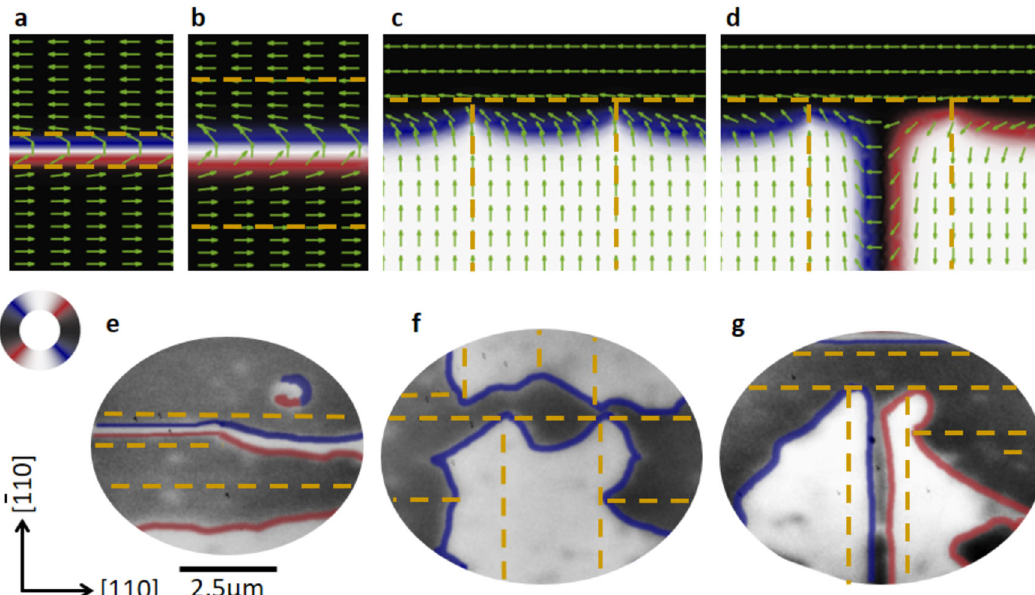
Fig. 4 Micromagnetic simulations. a – d Micromagnetic simulations of the AF domain structure in areas with different microtwin patterns (indicated by the broken yellow lines). a , b Feature parallel microtwins 2 domain wall widths apart ( a ) and two 7 domain wall widths apart ( b ). c , d The simulation results for different initial conditions for the same microtwin pattern of one perpendicular and two parallel microtwins forming two T-junctions. The green arrows (in a – d ) and color wheel show the local orientation of the Néel vector. e – g XMLD-PEEM images of AF domains overlaid with the microtwin pattern measured in XLD-PEEM (yellow broken